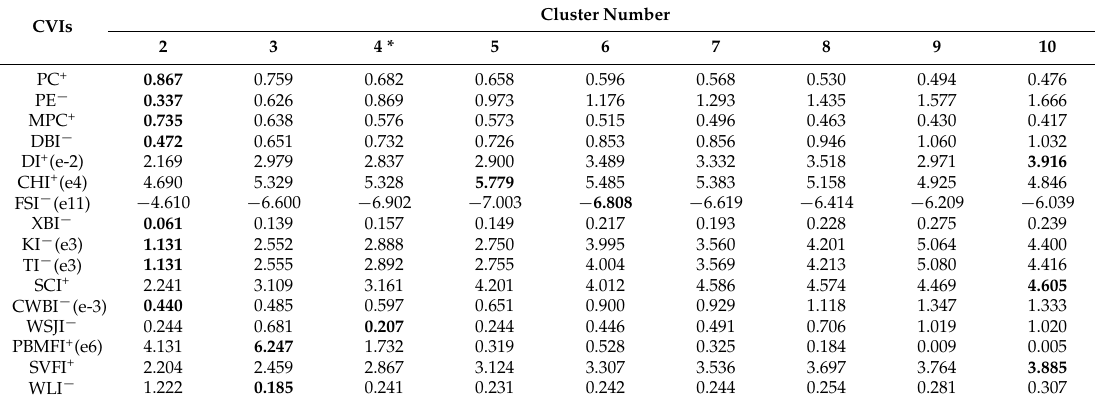
Table 8. Variations of the 16 CVIs with cluster numbers ranging from 2 to 10 for the Hyperion image. CVIs